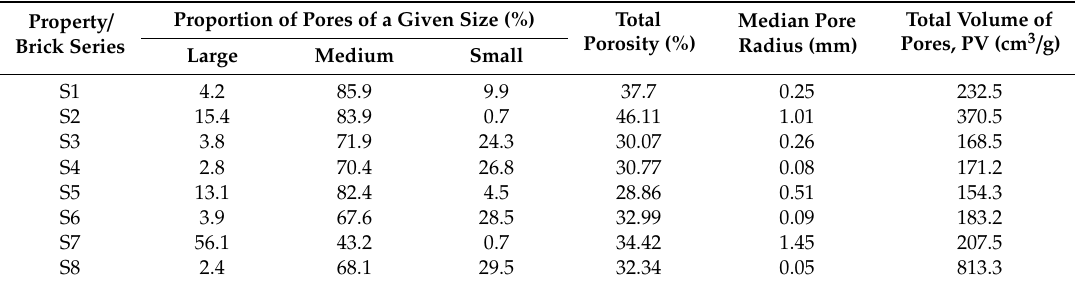
Figure 2. Pore size distribution in the brick series; ( a ) pore size distribution in brick series S1–S4; ( b ) pore size distribution in brick series S5–S8. Table 2. Proportion of pores of a given size, total porosity, median pore radius and total pore volume in the bricks.